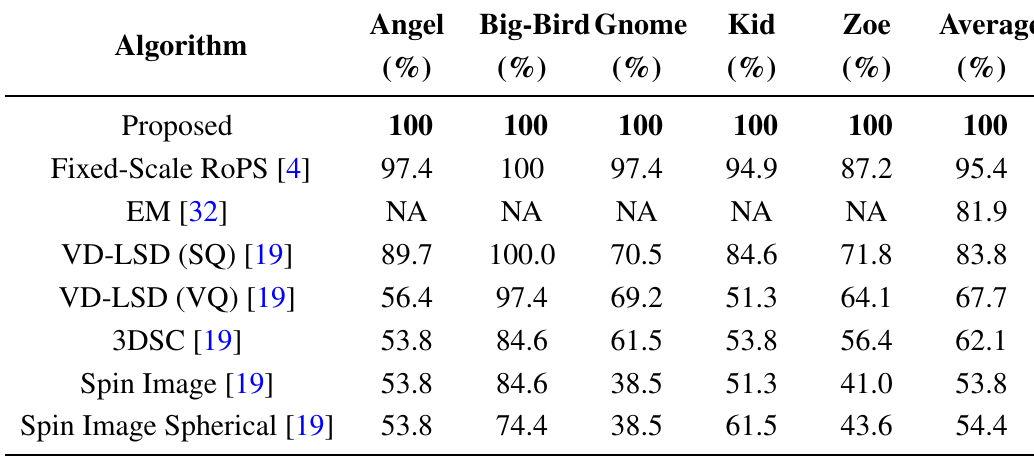
Table 3. Recognition rates on a subset of the Queen’s dataset. The best results are in bold face. 3DSC, 3D shape